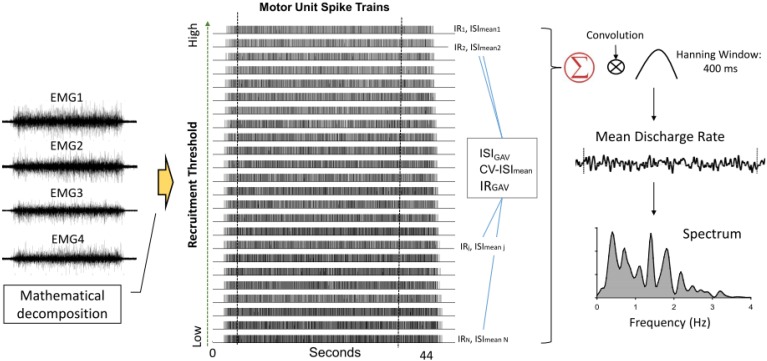
Acquisition of variables of inter-spike interval and mean discharge rate following mathematical decomposition of surface EMG into motor unit spike trains. Mean discharge interval (ISImean) and irregularity index (IR) of each spike train are determined. The global averages of ISImean and IR, as well as coefficient of variance of ISImean (CV-ISImean) among motor units (MUs). Mean discharge rate is obtained by smoothing the cumulative MU spike trains following convolution with a Hanning window (window length: 400 ms). Spectral distributions of mean discharge rate are estimated.